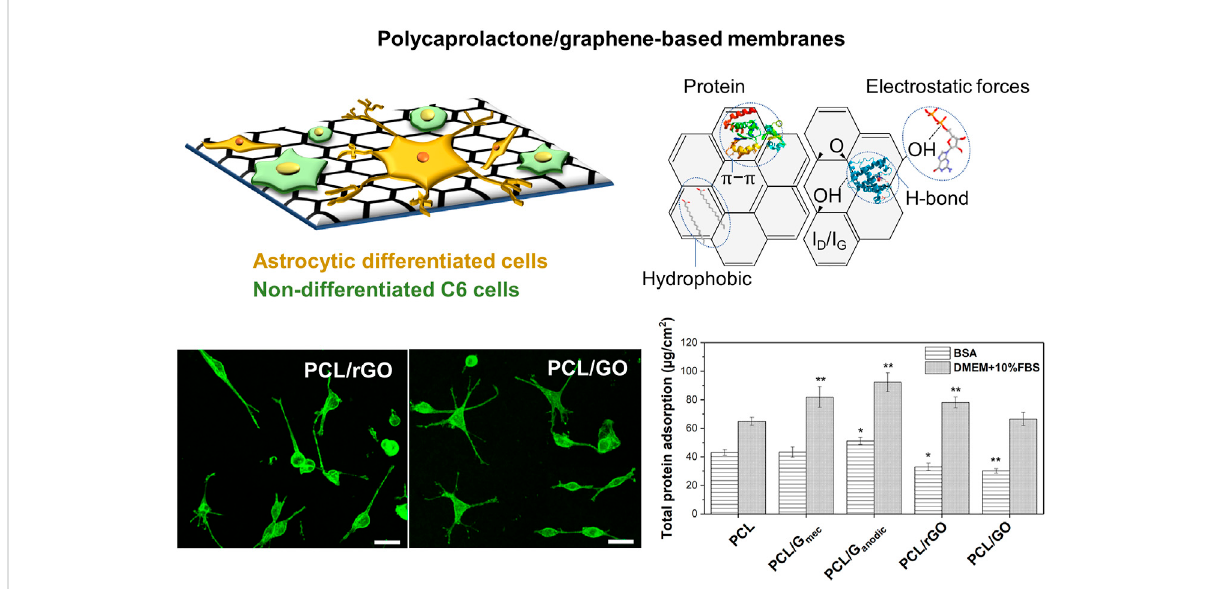
FIGURE 6 Defectivegraphene-basednanomaterialsuniformlydispersedinPCL fl atmembranesurfacesigni fi cantly favoredcell anchorage andastrocytic differentiation via chemical structural defects and protein selective adsorption. Confocal images depict the morphological analysis of C6 cells stained with Phalloidin-FITC and differentiated towards astrocytes on PCL/rGO and PCL/GO fl at membranes. The total protein adsorption of BSA model protein and cell culture media (DMEM +10% FBS) on PCL and PCL/GBN fl at membranes is also presented. Statistical signi fi cance with respect to PCL (* p < 0.05; ** p < 0.01). Reprintedwith permission from (Mantecón-Oria etal., 2022), Creative Commons Attribution 4.0 International